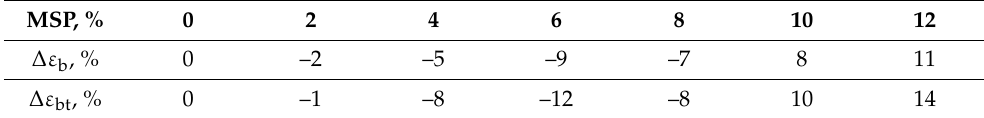
Table 6. Changes in USAC and USAT.